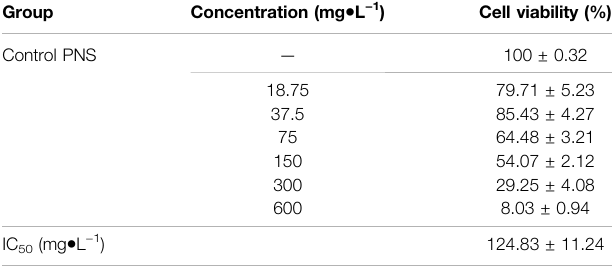
TABLE 2 | Effects of PNS on cell viability of HepG2 cells ( ‾ x ± s , n (cid:2) 3).